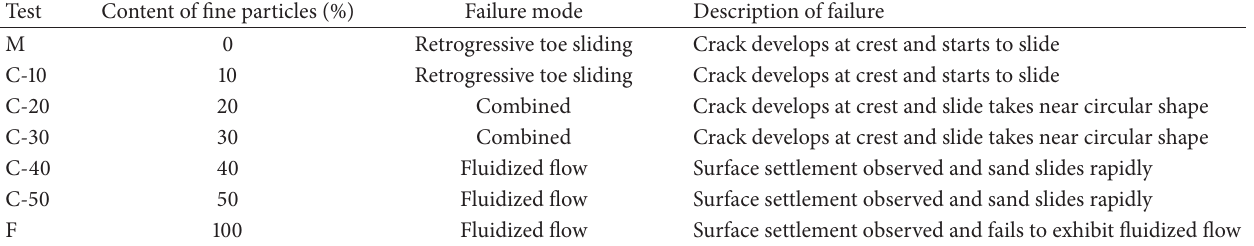
Table 2: Failure description of the sand slopes.